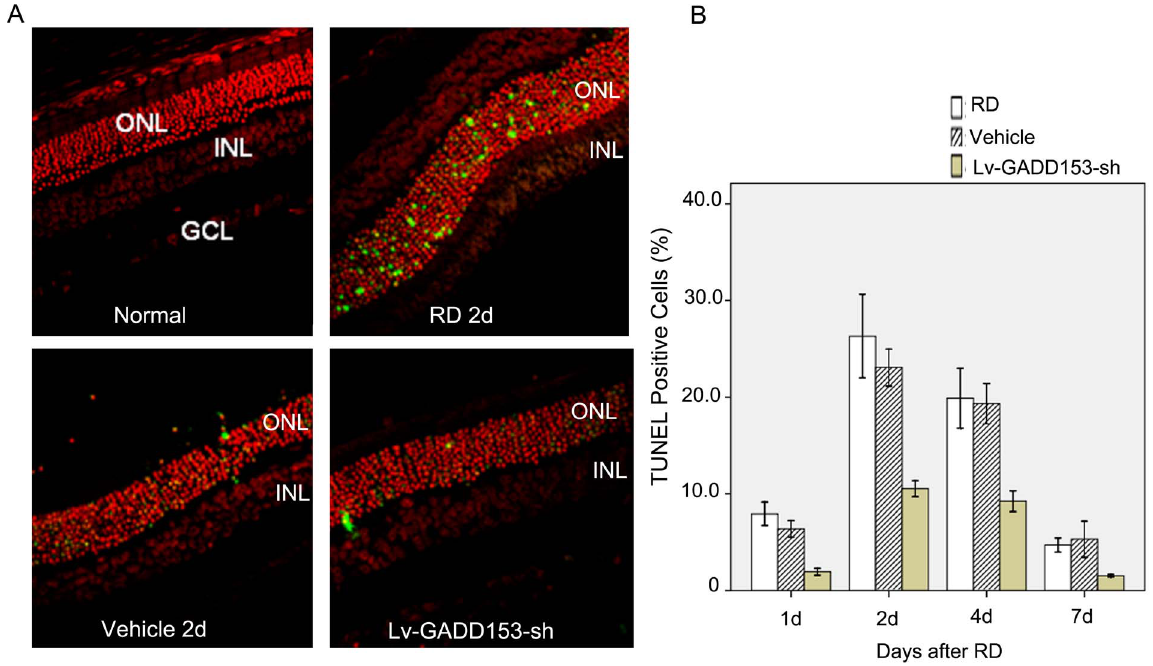
Figure 3. GADD153 RNA interference decreased TUNEL cell counts after RD in vivo. (A) Representative retinal sections from rats on 2 days after RD. No TUNEL-positive cells were observed in normal control group. The TUNEL-positive cells in ONL increased after retinal detachment. Most TUNEL-positive cells were located in the ONL layer. Compared with retinal detachment group, TUNEL-positive cells decreased in RNA interference group (LV-GADD153-sh) but not in vehicle group. (B) TUNEL-positive cells in ONL increased first and then decreased after retinal detachment, with the highest expression found at 2 days after detachment and the lowest at 7 days after detachment. Compared with retinal detachment group, TUNEL-positive cells decreased at all time points after retinal detachment in GADD153 RNAi